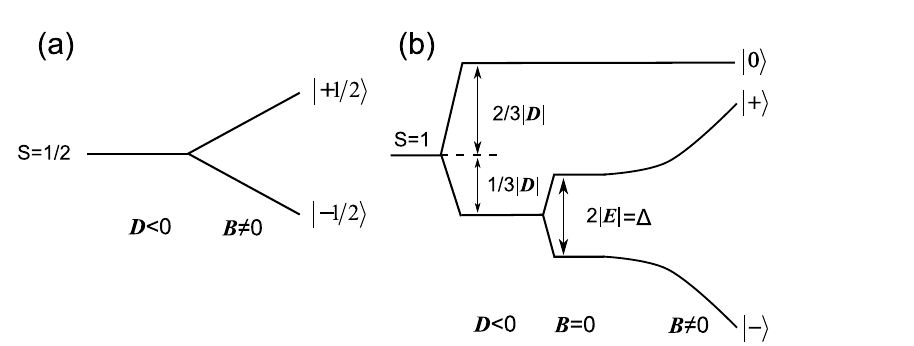
Figure 4. Energy level diagrams corresponding to ( a ) S = 1/2 and ( b ) S = 1 effective spin in the assumption of the Hamiltonian